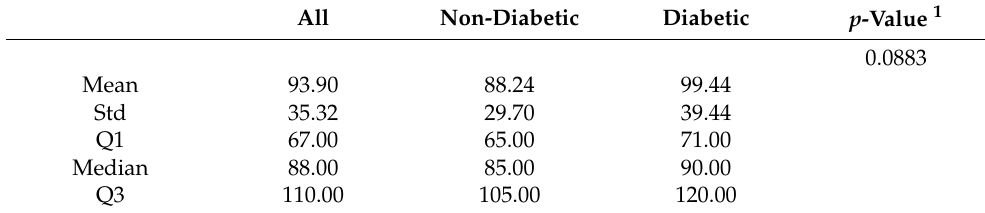
Table 2. Summarized statistics of LDL-C by non-diabetics and diabetics.